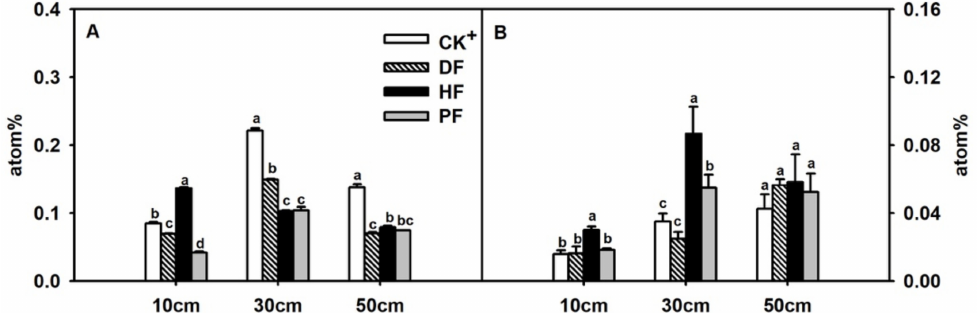
Figure 3. Enrichment of 15 N in different soil depth at ( A ) citrus fruit enlargement and ( B ) fruit maturity stages. The data are presented as mean ± SD n = 3. Different letters indicate significant differences at p < 0.05, Duncan’s test.